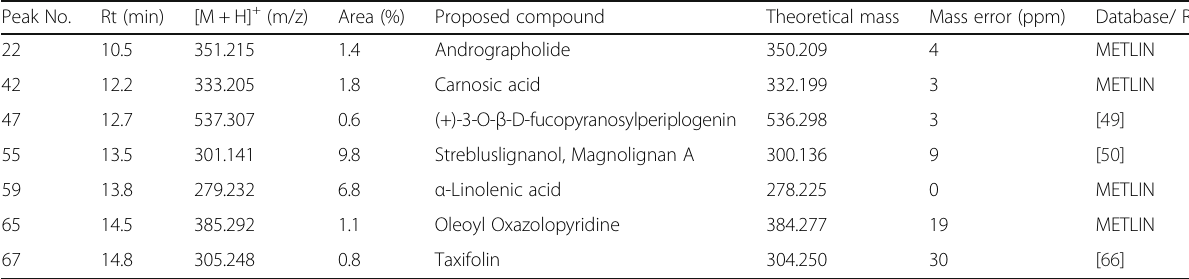
Table 3 Proposed phytochemical constituents in SA-EE Peak